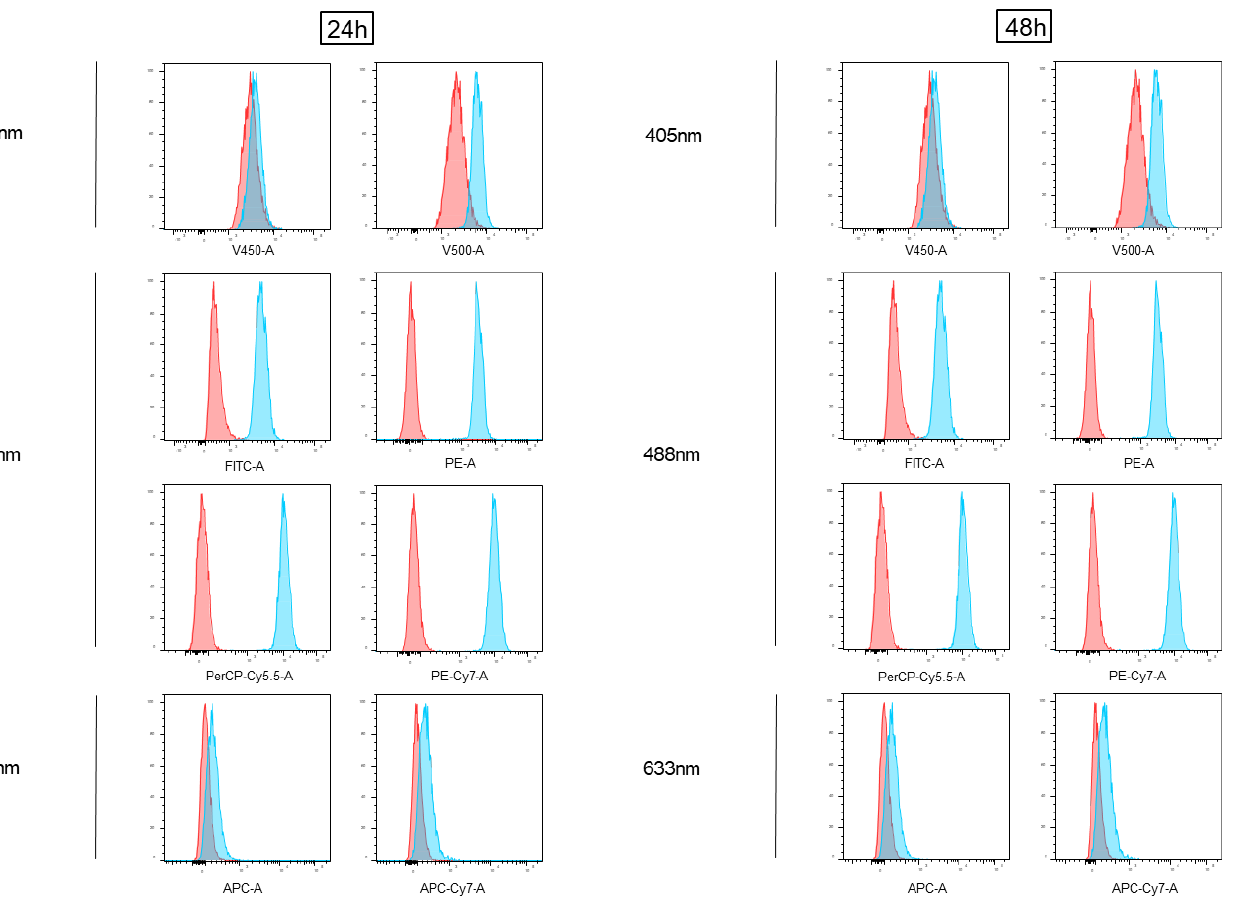
Figure 1. Analysis of doxorubicin fluorescence emission via conventional flow cytometry (BD FACSVerse). Cells treated with 2.5 µM doxorubicin (Doxo) for 24 and 48 h were acquired using flow cytometry and shown as blue histograms on every channel of a conventional instrument (FACSVerse, BD Biosciences), equipped with three lasers (488 nm, 633 nm, and 405 nm). Overlayed red histograms show the profiles of matched untreated samples. Histograms are representative of three independent experiments.